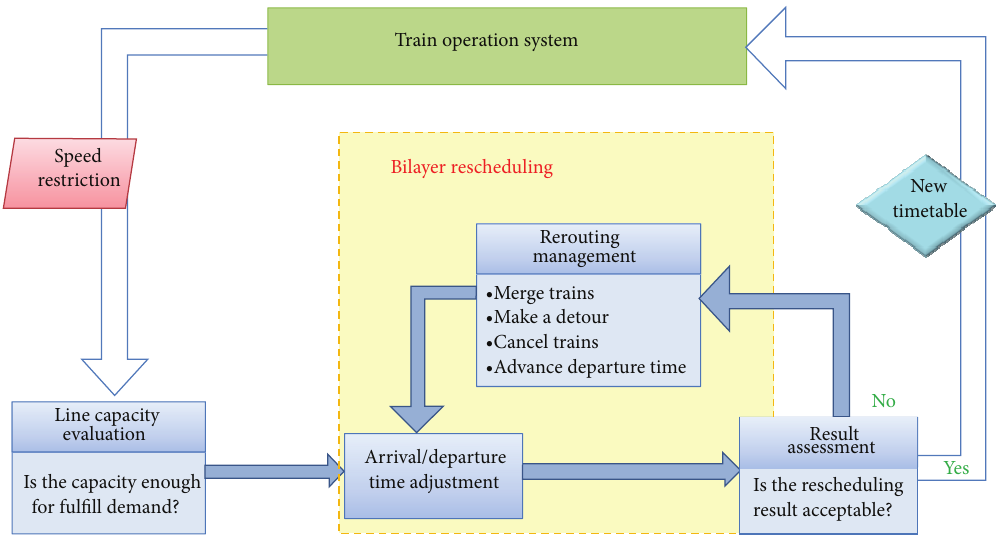
Figure 1: Architecture of the decision support mechanism.